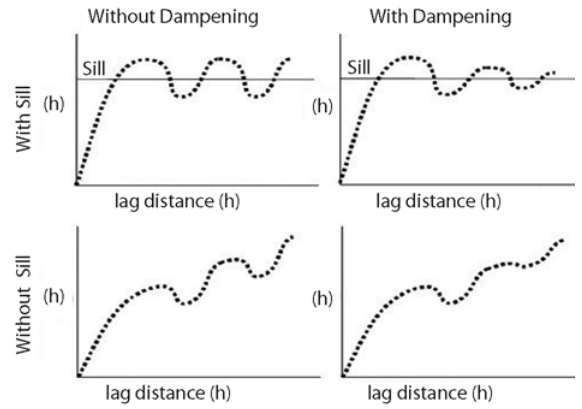
Fig. 5. Hole effect configurations (Deutsch 2002) Fig. 6. Hole effect interpretations in regular strata and irregular strata based on indicator data (Deutsch 2002)